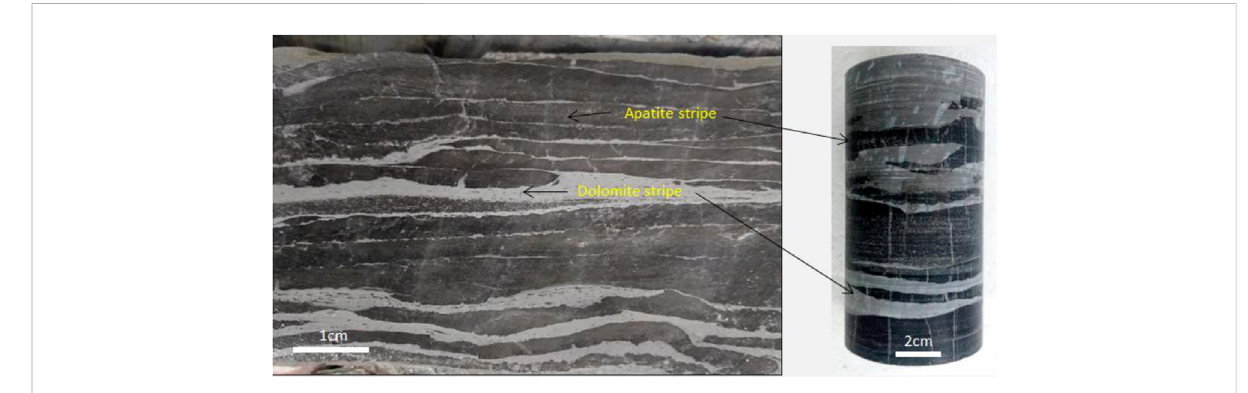
FIGURE 1 Cyclothymic deposition structure of phosphate